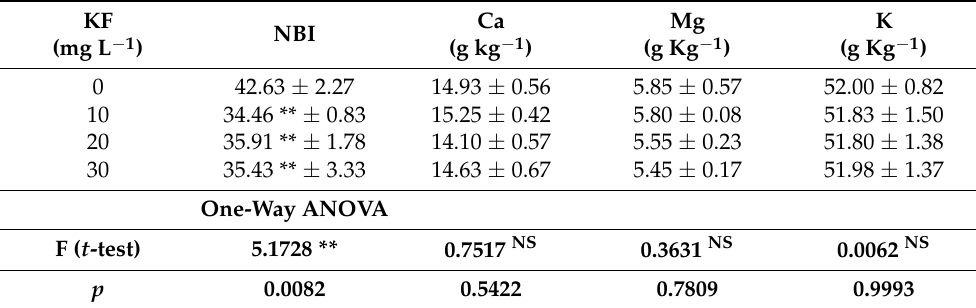
Table 4. Nitrogen balance index (NBI) and calcium (Ca), magnesium (Mg), and potassium (K) levels in Lactuca sativa L. leaves after 40 days of exposure to 0 mg L − 1 , 10 mg L − 1 , 20 mg L − 1 , and 30 mg L − 1 potassium fluoride